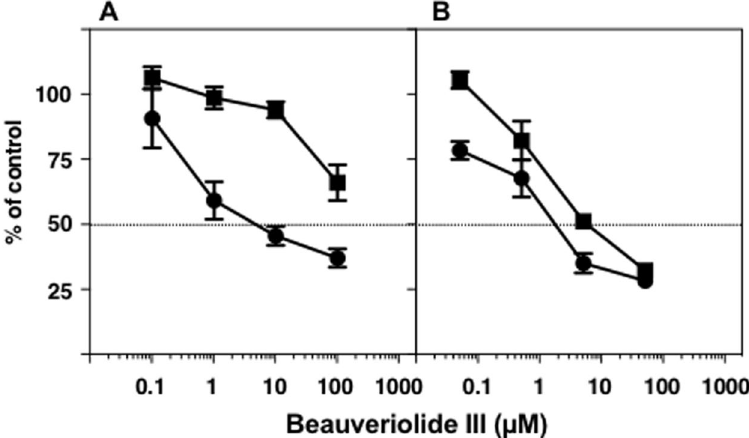
Figure 3. Inhibition of SOAT1 and SOAT2 by BeauIII in semi-intact SOAT1- and SOAT2-CHO cells. SOAT1-/ SOAT2-CHO cells were permeabilized by digitonin ( A ) or saponin ( B ). [ 14 C]CE was synthesized from [ 14 C] oleoyl-CoA in semi-intact SOAT1- ( ● ) and SOAT2-CHO ( ■ ) cells. The results obtained were plotted as % of control (without drugs). Values represent the means ± SD (n =